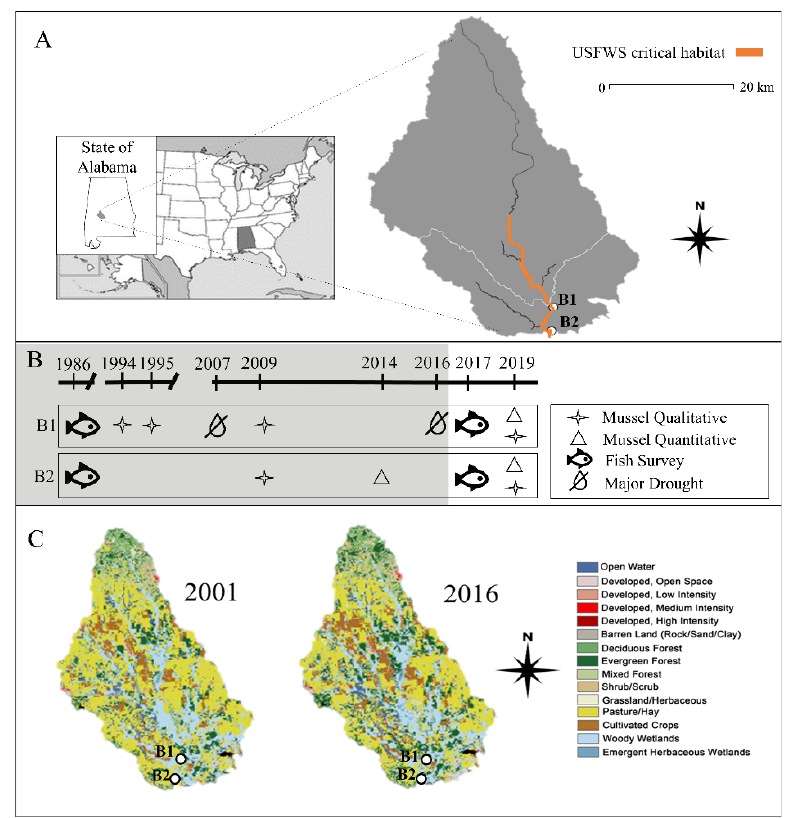
Figure 1. ( A ) Map of the sites sampled in Bogue Chitto Creek Watershed. ( B ) Timeline of the survey methodology used at each site and major drought events. Grey represents data considered historical. ( C ) Land cover in the Lower Bogue Chitto Creek watershed in 2001 and 2016. The predominant land uses in the watershed are forestland and agriculture [31]. The creek also has high nutrient concentrations in comparison to other streams, as its flow- weighted total nitrogen concentration (3.90 mg/L) is within the upper 20% of 479 rivers sampled under the National Water Quality Assessment (NWQA) [32]. Additionally, − 3.99) in August 2007 [33] and an extreme drought (PDSI < − 4) that occurred for